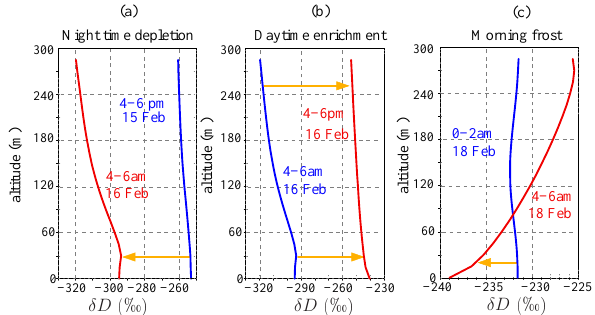
Fig. 6. Profiles of δ D for specific events that illustrate diurnal vari- ations that can be captured by a mixing line analysis: (a) depletion associated with nocturnal mixing, (b) daytime enrichment from sur- face source, (c) frost formation. The red curve occurs several hours after the blue profile, and the evolution is indicated by the